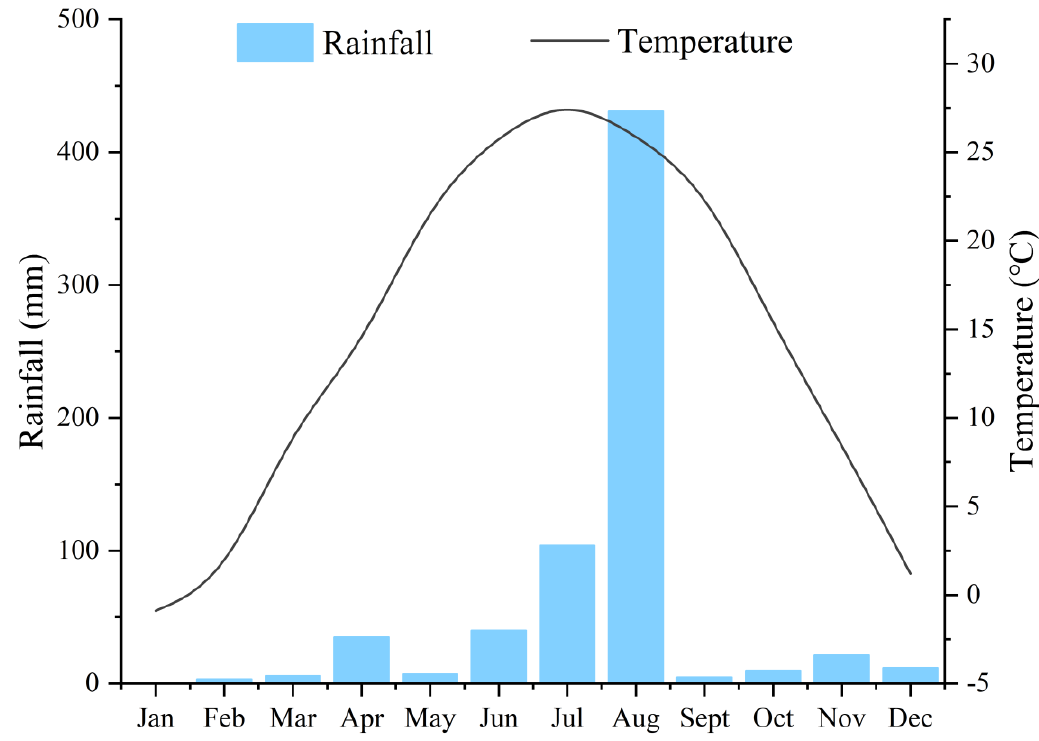
Figure 1. Monthly rainfall and average temperature.